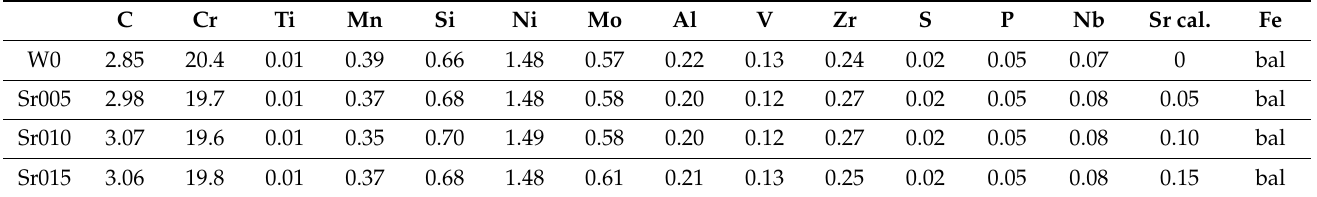
Figure 4. Scheme of mold cross-section (ATD-P tester); casting 3D model [1,4]. Table 1. Chemical composition of experimental samples, % weight (spectrometric analysis), bal-